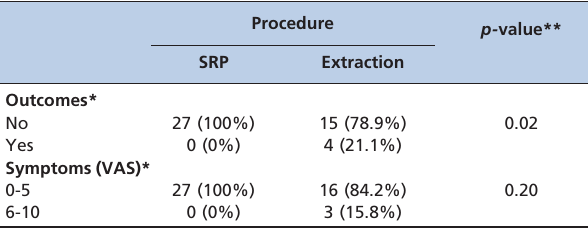
Table 2 - Frequency of type 2 diabetic patients presenting outcomes and symptoms based on the type of dental